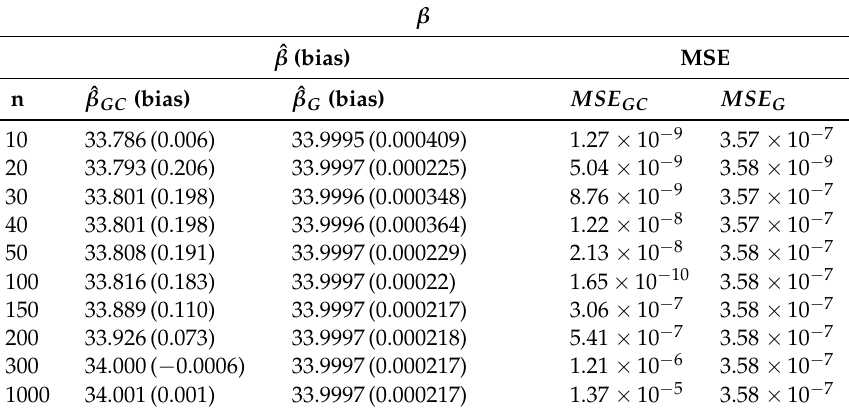
Table 5. MLEs of β with the conjugate gradient method and gradient method.